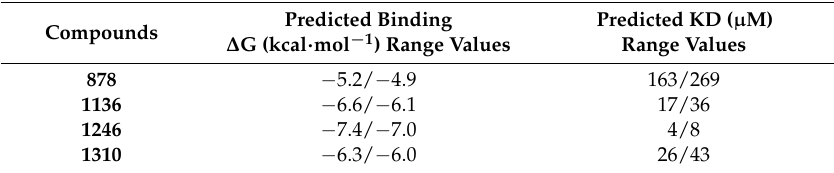
Figure 6. Representation of the CA monomer and the different docking studies from the selected compounds. ( A ) The monomer of CA in cartoons; ( B ) The CA surface accessible to the solvent, computed using PyMol. The best scored positions after docking on CA ( left panel ), with a close-up view ( right panel ) of the binding region (red square) for ( C ) compound 878 ; ( D ) compound 1136 ; ( E ) compound 1246 ; and ( F ) compound 1310 . Table 1. Data from docking studies with the active compounds identified in the in vitro assay with